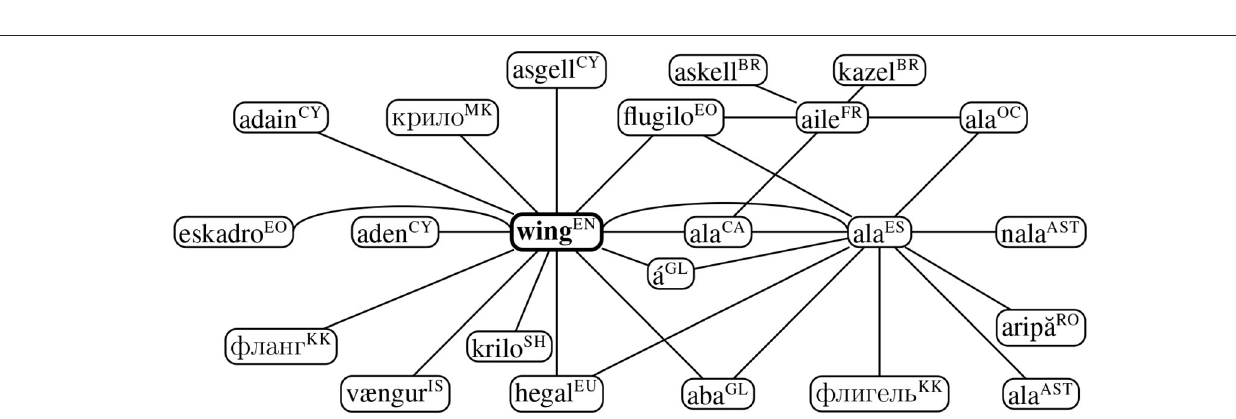
other sense distinctions appear that would not be obvious to